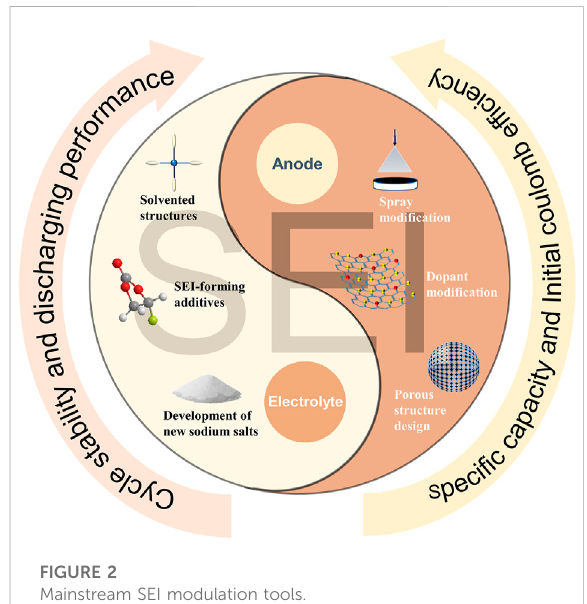
Mainstream SEI modulation